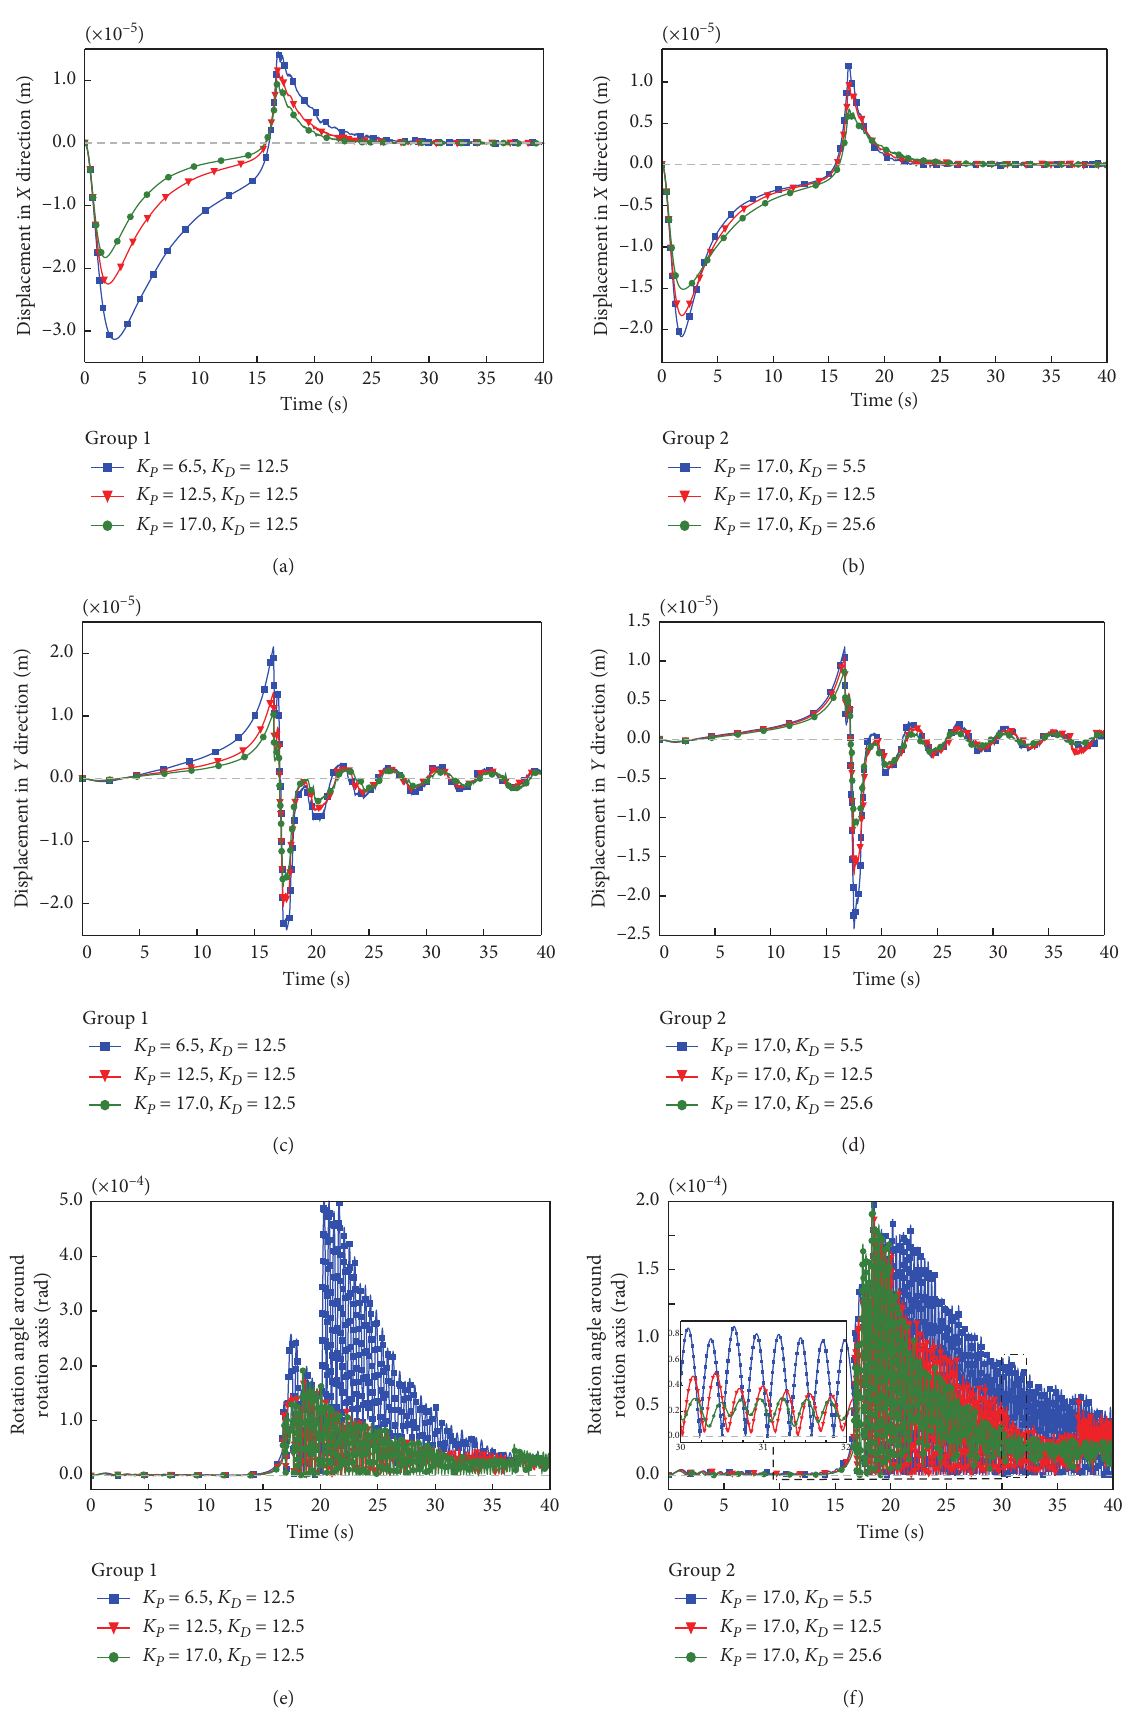
Figure 16: Position and attitude responses of the spacecraft varying with PD controller